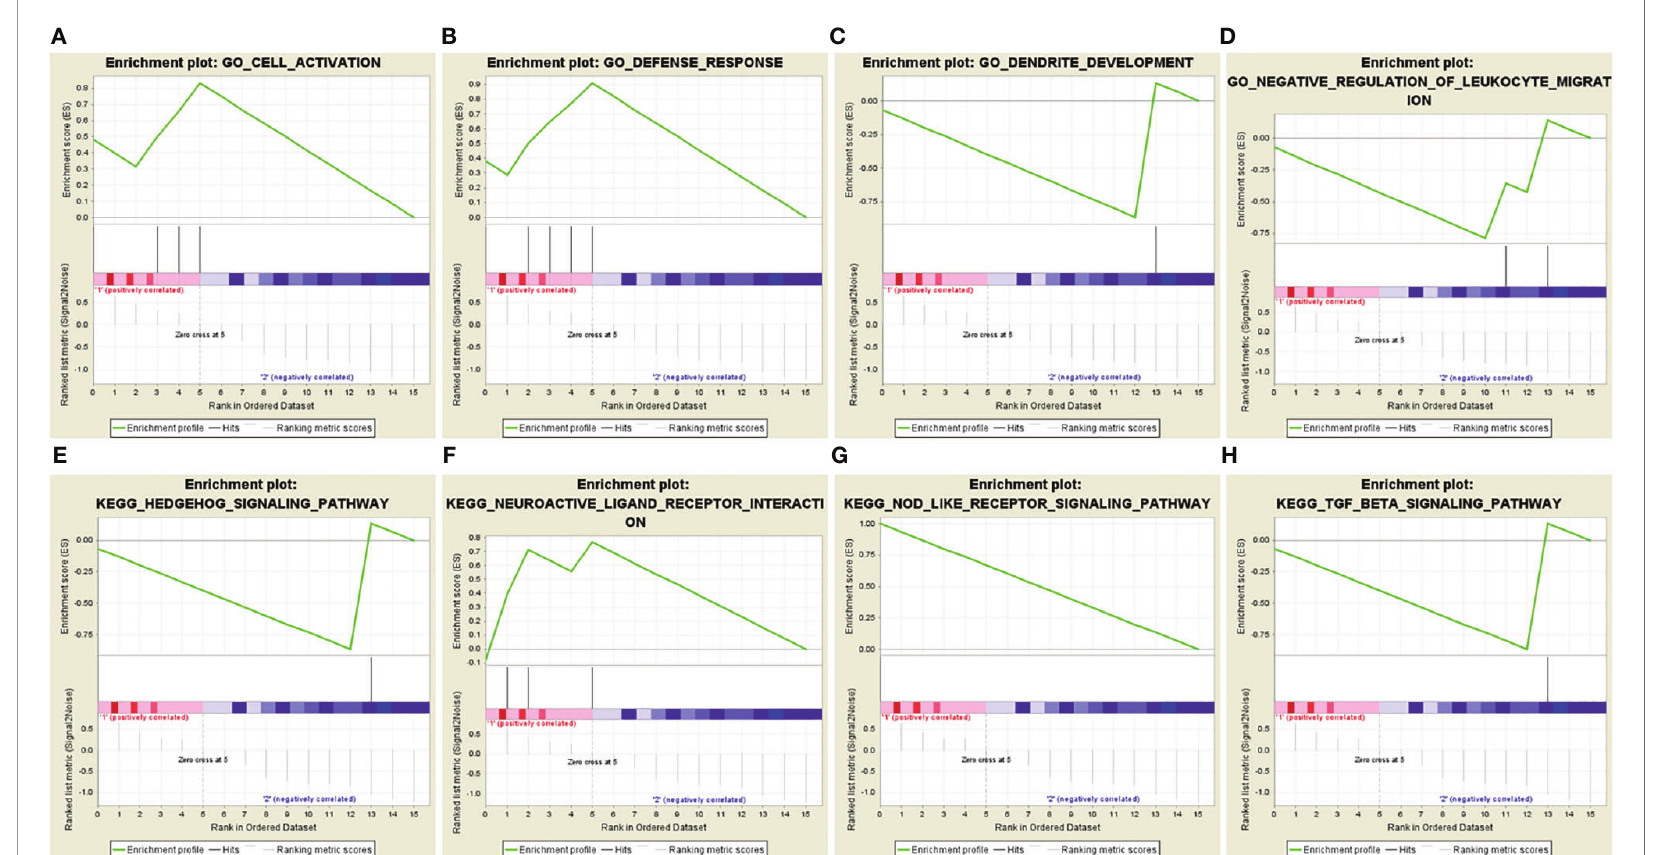
FIGURE 4 | Gene set enrichment analysis of 16 prognostic immune-related genes. (A – D) GSEA in gene ontology (GO). (E – H) GSEA in KEGG